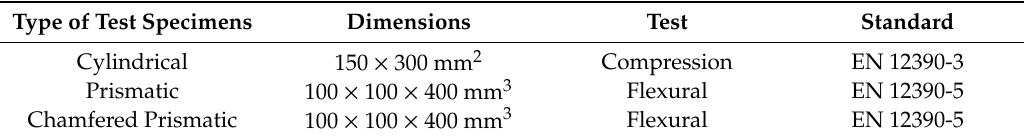
Table 3. Experimental